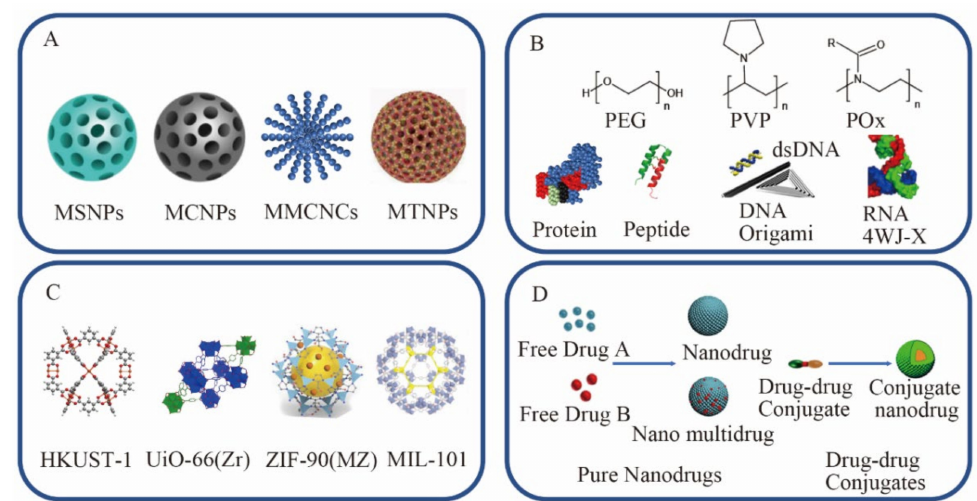
Figure 4. Summary of carrier drugs composed of different carriers. ( A ) Inorganic carrier nano